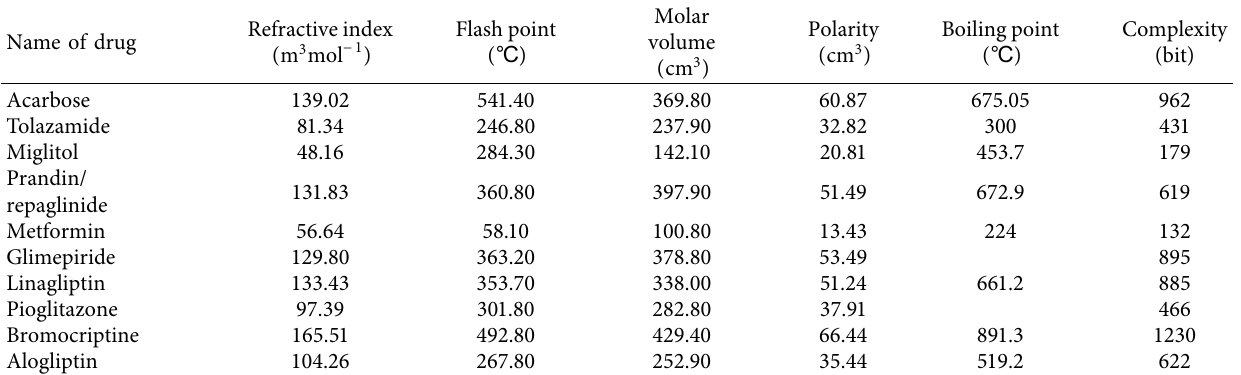
Table 12: Physical properties of